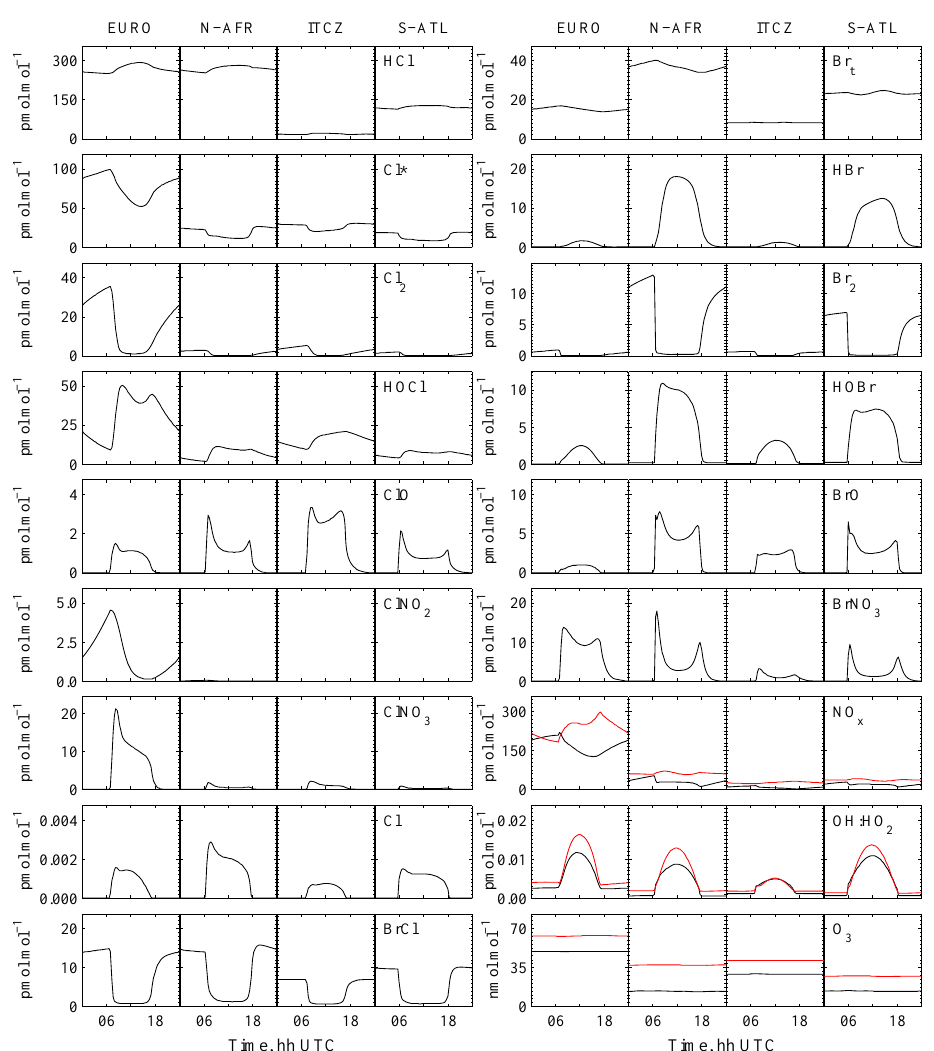
Figure 8. Fig. 8. Simulated diel cycles in mixing ratios of gas-phase species for the four flow regimes; values for runs “with halogens” are in black and those with “no halogens” are in